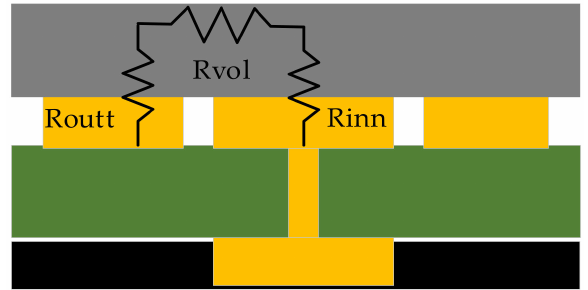
Figure 7. The equivalent resistance of a tactile